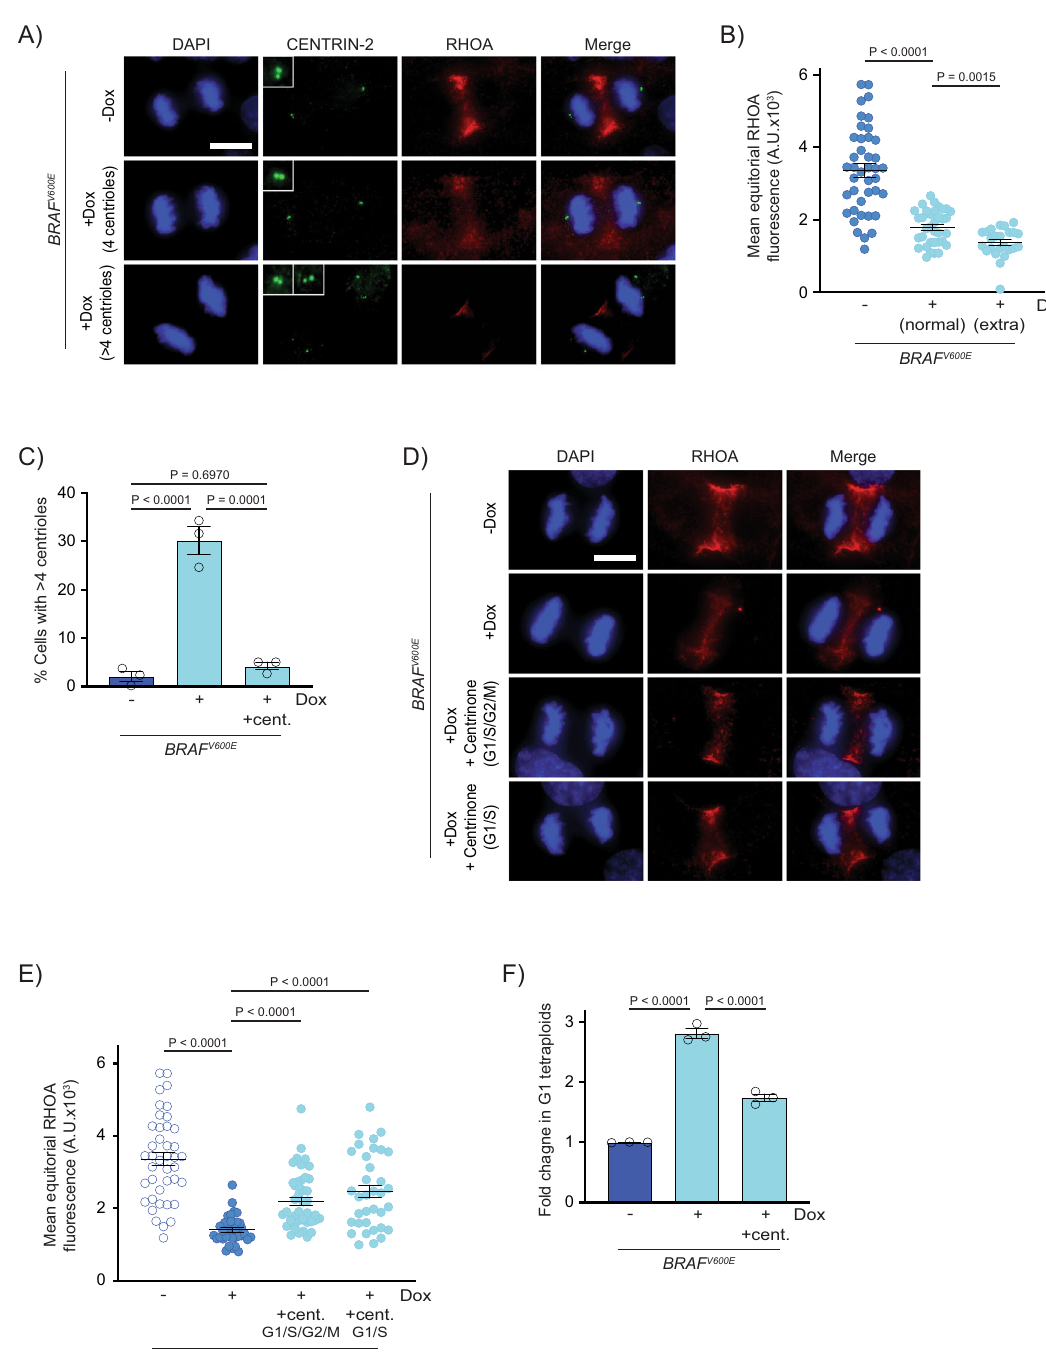
BRAF V600E -inducible RPE1-FUCCI cell clone. We isolated a clone in which both P53 alleles were targeted and P53 protein expression abrogated (Supplementary Fig. 7C, D). These cells had DNA content pro fi les similar to P53 wild-type parental cells (Supplementary Fig. 7E, F). As compared to parental BRAF V600E - inducible RPE1-FUCCI cells, BRAF V600E -induclible P53 − / − RPE- 1 FUCCI cells had a lower fraction of G1 tetraploids following BRAF V600E expression (Supplementary Fig. 7G, H), consistent with the notion that an arrest of G1 tetraploids was bypassed in P53 − / − cells. Such a failure to arrest would be evidenced by the presence of Geminin-GFP-positive S/G2/M cells with a >4N DNA content. Such cells were present at a much higher